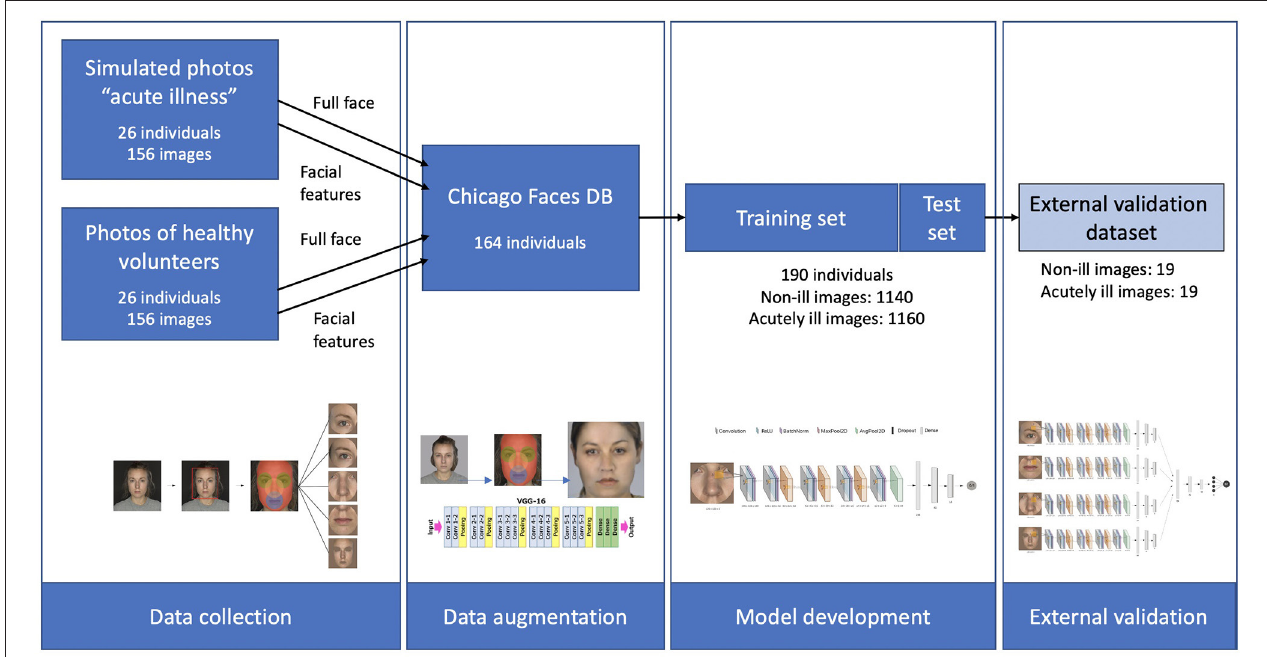
FIGURE 1 | Schematic overview of the three datasets, and of the different steps in the study. Starting with data collection from 26 healthy individuals and simulated acute illness. These features were then extracted and transferred to 164 faces from the Chicago Faces database, resulting in a total of 2,300 images of healthy and acutely ill individuals. After training the deep learning algorithm, validation was carried out on an external dataset of 19 individuals using a stacked CNN combining 4 individual